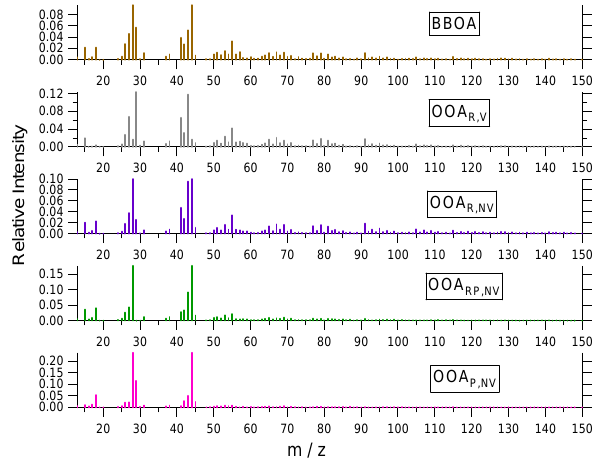
Fig. 10. Effect of OH exposure on PMF factor concentrations. Changes in factor mass are shown as the ratio of AmbUVOH to AmbUV conditions for OOA R , V , OOA R , NV , and OOA RP , NV (top panel) and as the difference between these conditions for OOA P , NV (bottom panel) due to the sometimes low AmbUV mass concen- trations for this factor. Photochemical age is estimated assum- ing a mean OH concentration of 2 × 10 6 moleccm − 3 . OOA R , V , OOA R , NV , and OOA P , NV are fitted to y =1 + a (1- e − kx ), while OOA RP , NV is fitted to a 3 rd -order